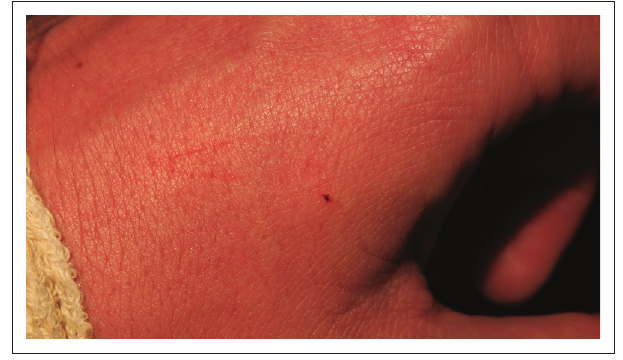
Source : Photo courtesy of patient. FIGURE 2 : Trivial wound with a single fang puncture mark and superficial scratch.